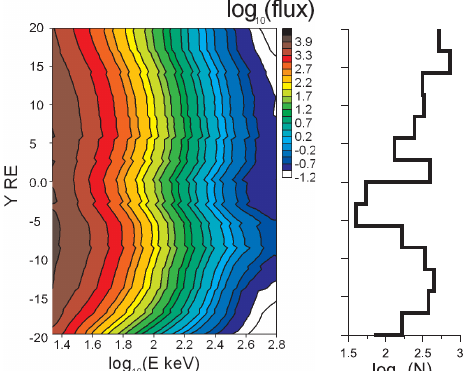
Figure 5. 2-D map of ion fluxes (measured in (scm 2 srkeV) − 1 ) as a function of Y coordinate. The right panel shows the number of events ( N ) for a given Y